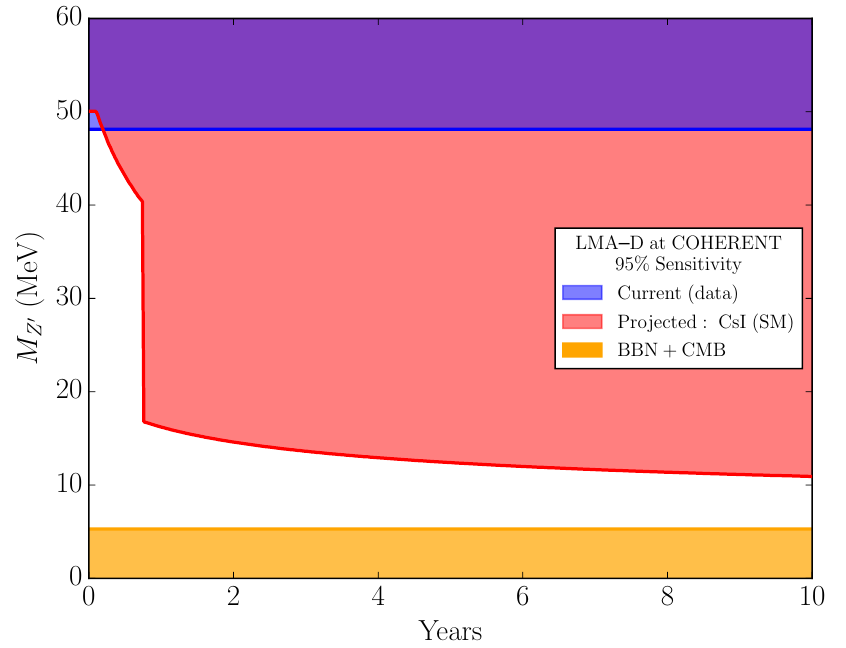
Figure 5 . Future sensitivity at 95% C.L. of COHERENT to the exactly degenerate LMA-Dark solution for di(cid:11)erent NSI mass scales M Z 0 including the marginalization over x . The horizontal axis shows the real time, and we assume 50% uptime. The blue region is the current exclusion limit as shown in (cid:12)gure 2. The red region is the predicted future exclusion range assuming true value of (cid:15) = 0 which becomes saturated at (cid:24) 10 MeV. The sharp drop occurs when the higher mass minimum seen in (cid:12)gure 2 passes the threshold. The orange region is the exclusion limit coming from BBN and CMB constraints [22]. Future measurements from reactor experiments like CONUS will reach the (cid:24) 1 MeV level and this (cid:12)gure will be completely